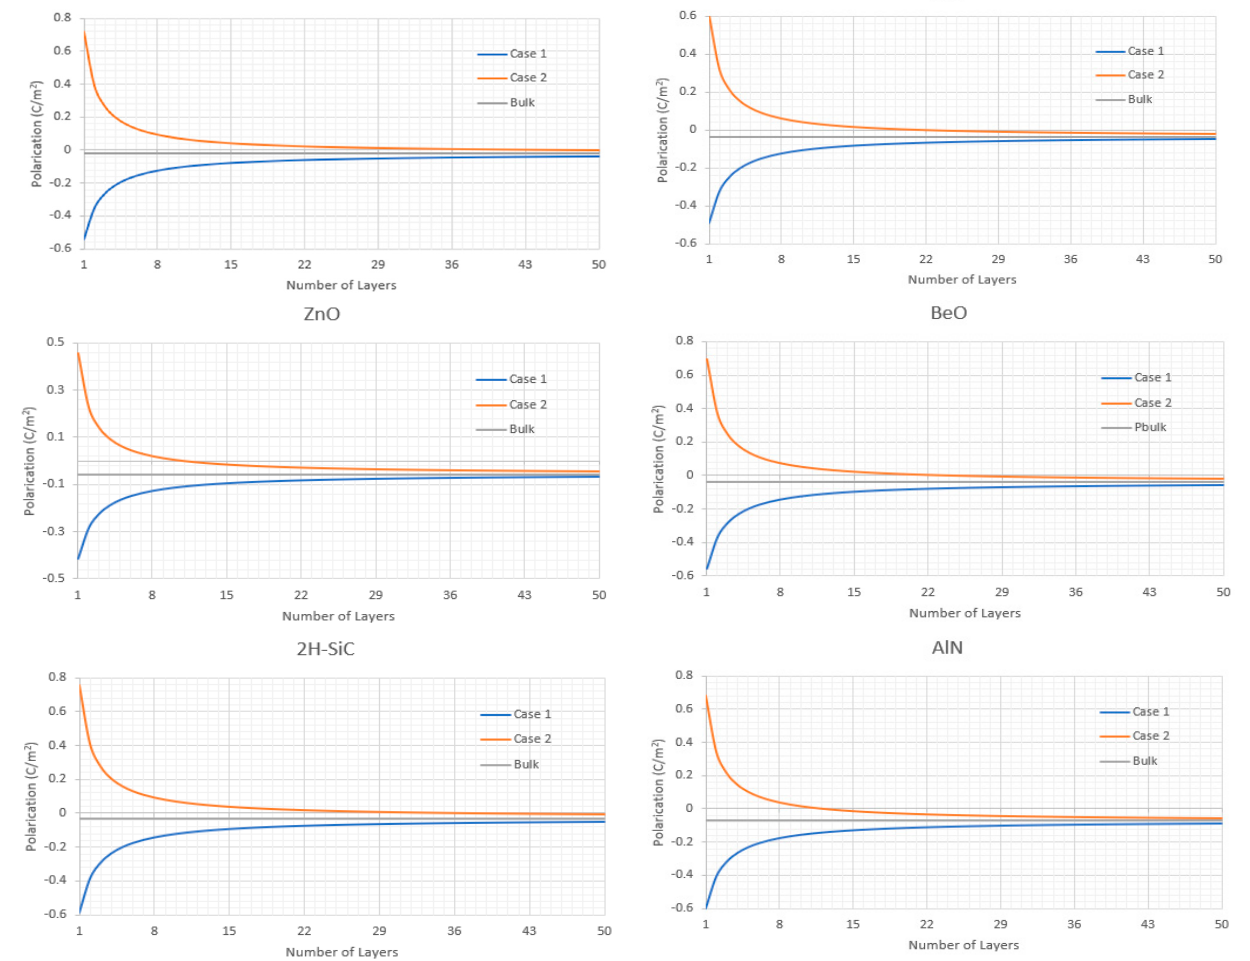
Figure 4. P sp as a function of the number of atomic layers for various pure hexagonal wurtzite structures.